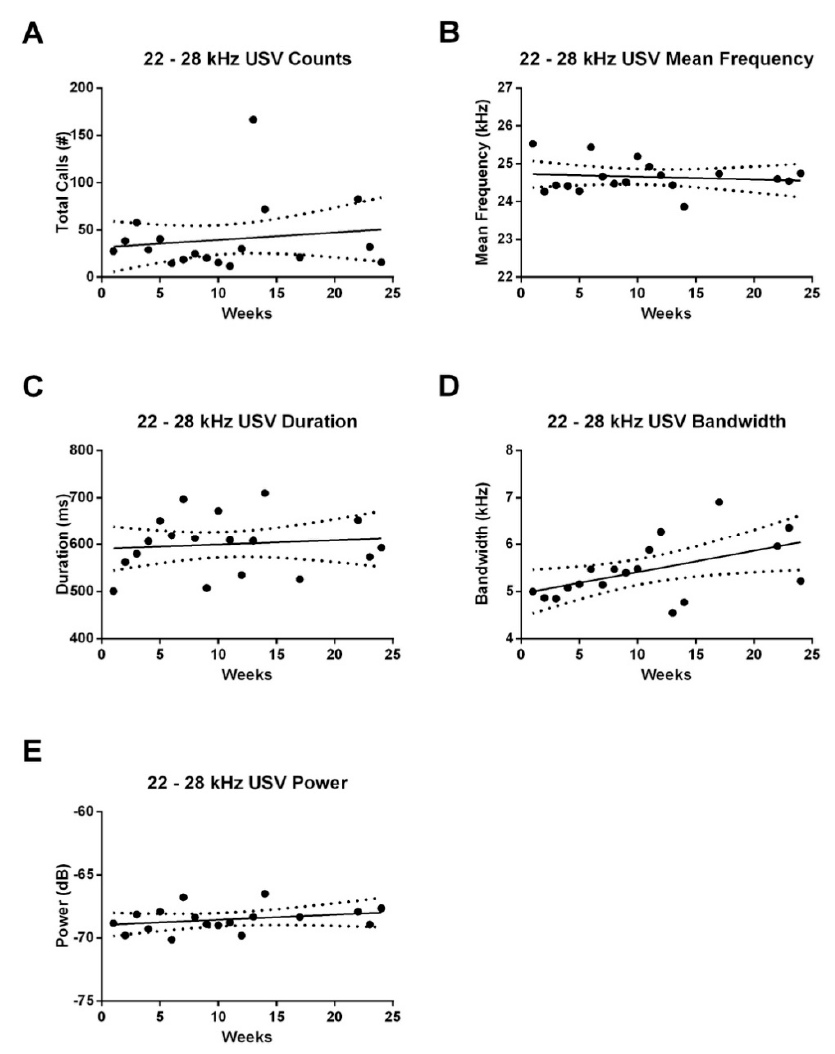
Figure 4. Correlation between age and 22–28 kHz USV counts and acoustic characteristics during the 4-h recording period. ( A ) There was no change in total 22–28 kHz USV counts as the animals aged. ( B ) Mean frequency or ( C ) duration of 22–28 kHz USVs did not vary with age. ( D ) There was an increase in bandwidth with age. ( E ) Power of these calls did not vary with age. Dots represent the group average across all control rats during each of the recording weeks.